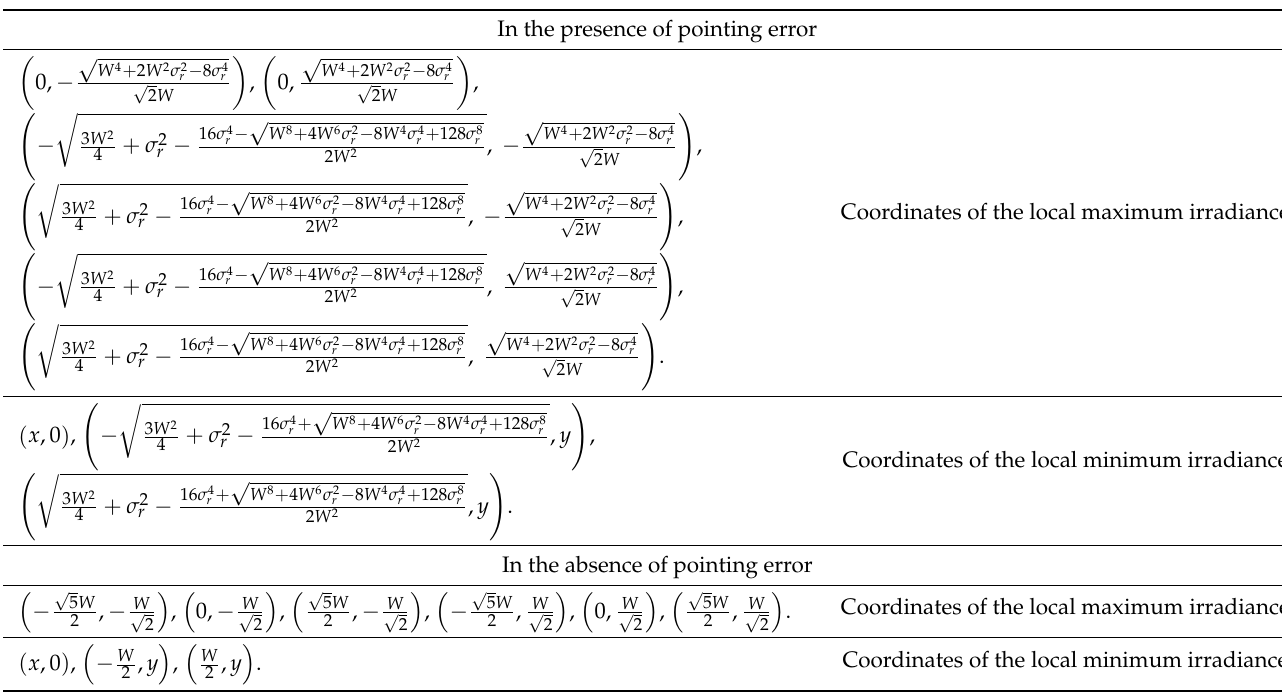
Coordinates of the local maximum irradiance